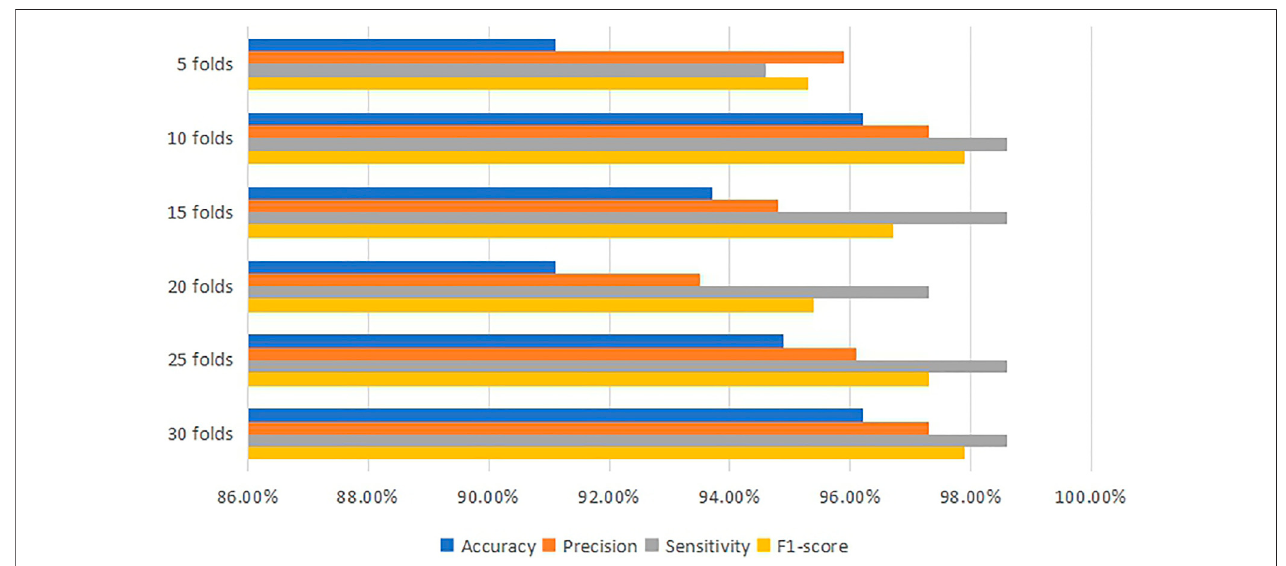
FIGURE 3 | Comparison diagram for the performance of DT classi fi er.